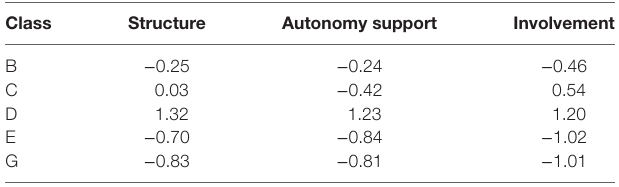
Table 4 | Effect sizes of teacher-student differences in structure, autonomy support, and involvement.